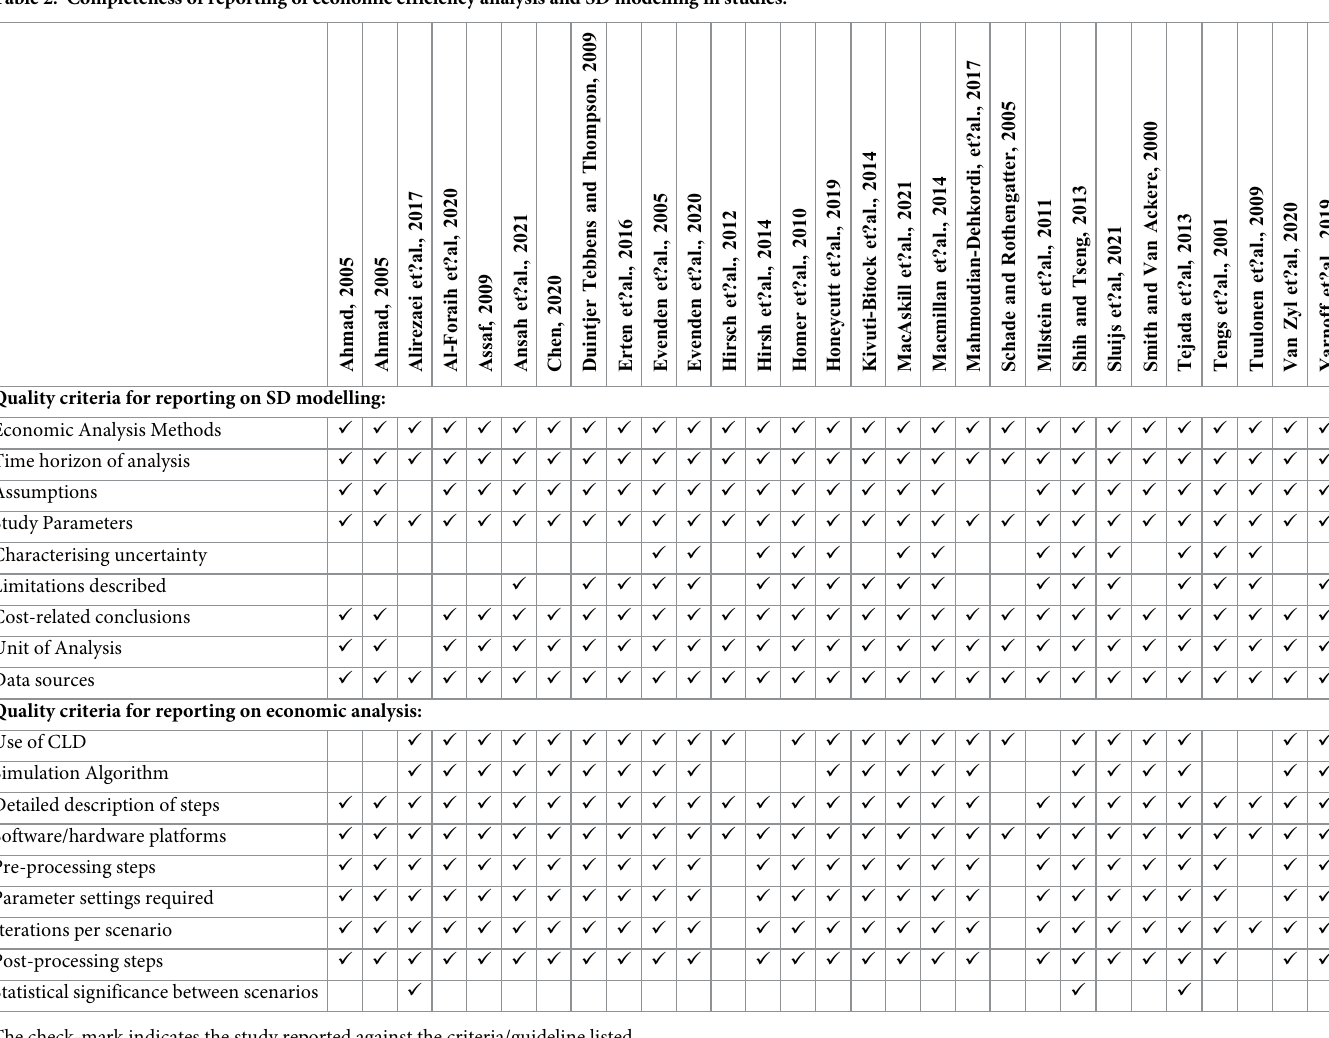
Table 2. Completeness of reporting of economic efficiency analysis and SD modelling in studies.